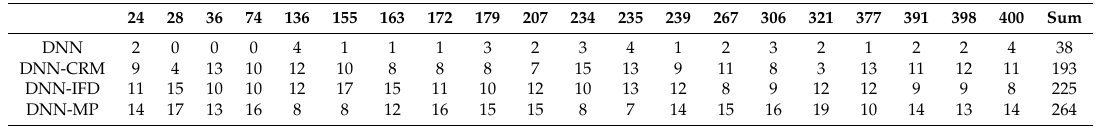
Table 6. Experiment 4: Subjective test